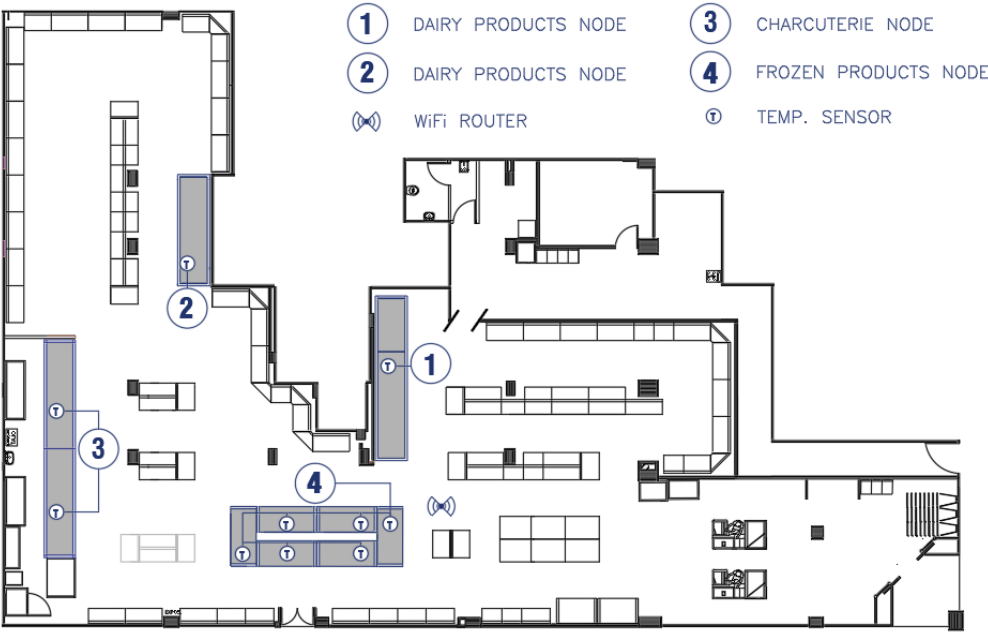
Figure 11. Layout of the installed elements in the store.